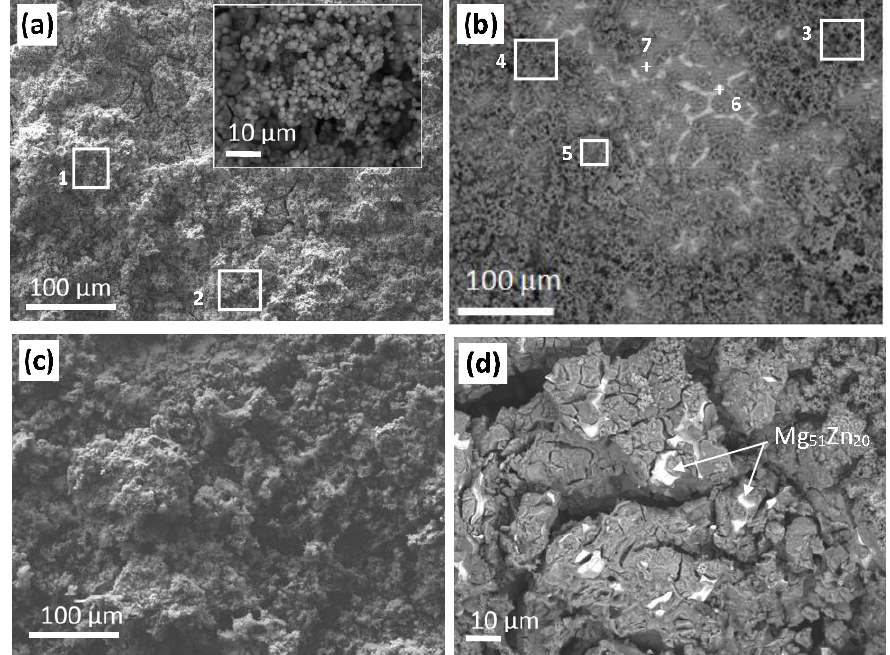
Figure 7. SEM images of ( a , b ) the Mg20Zn substrate ( c , d ) the Ca-P/chitosan_WG coating, after exposition for 110 h in the Hank’s solution at 37 °C.